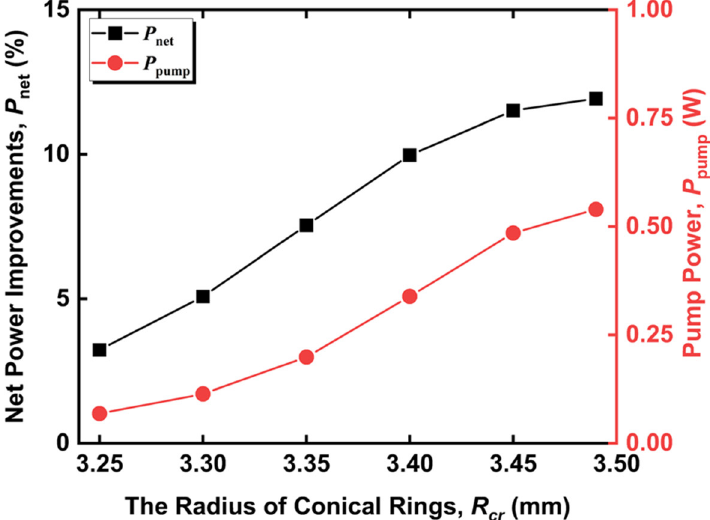
Figure 11. The percentage of the net power improvement and the required pump power as a func- tion of the conical ring radius. of the conical ring radius.